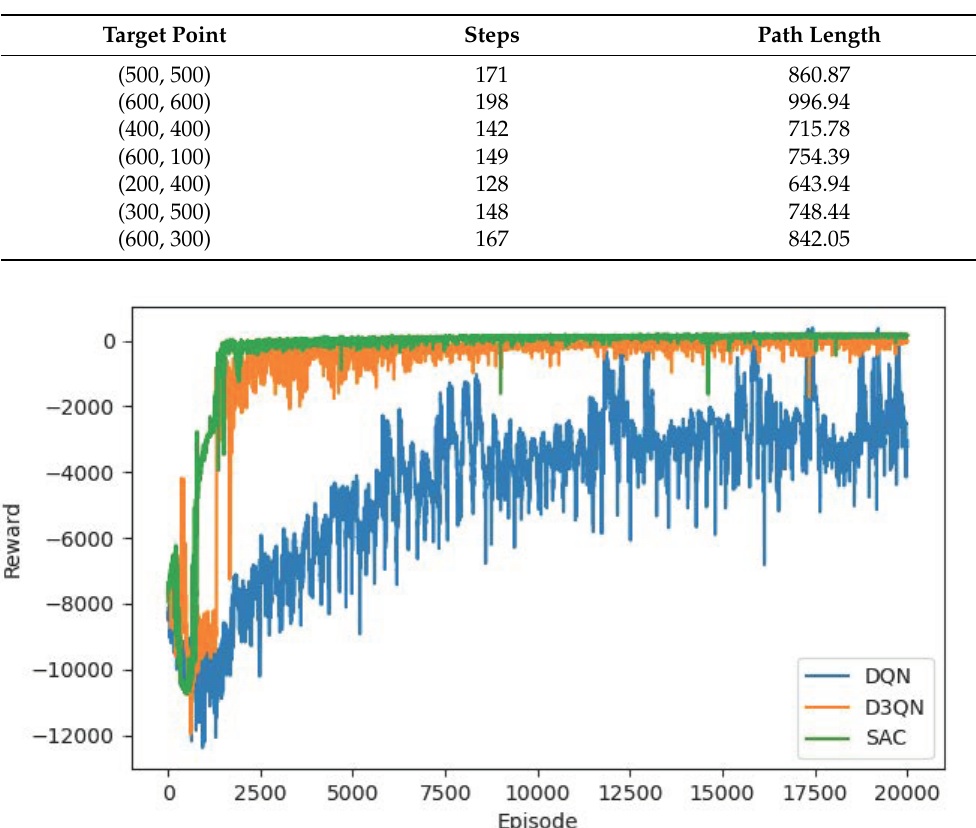
Table 3. The steps and path length of R-SAC algorithm with different target points.